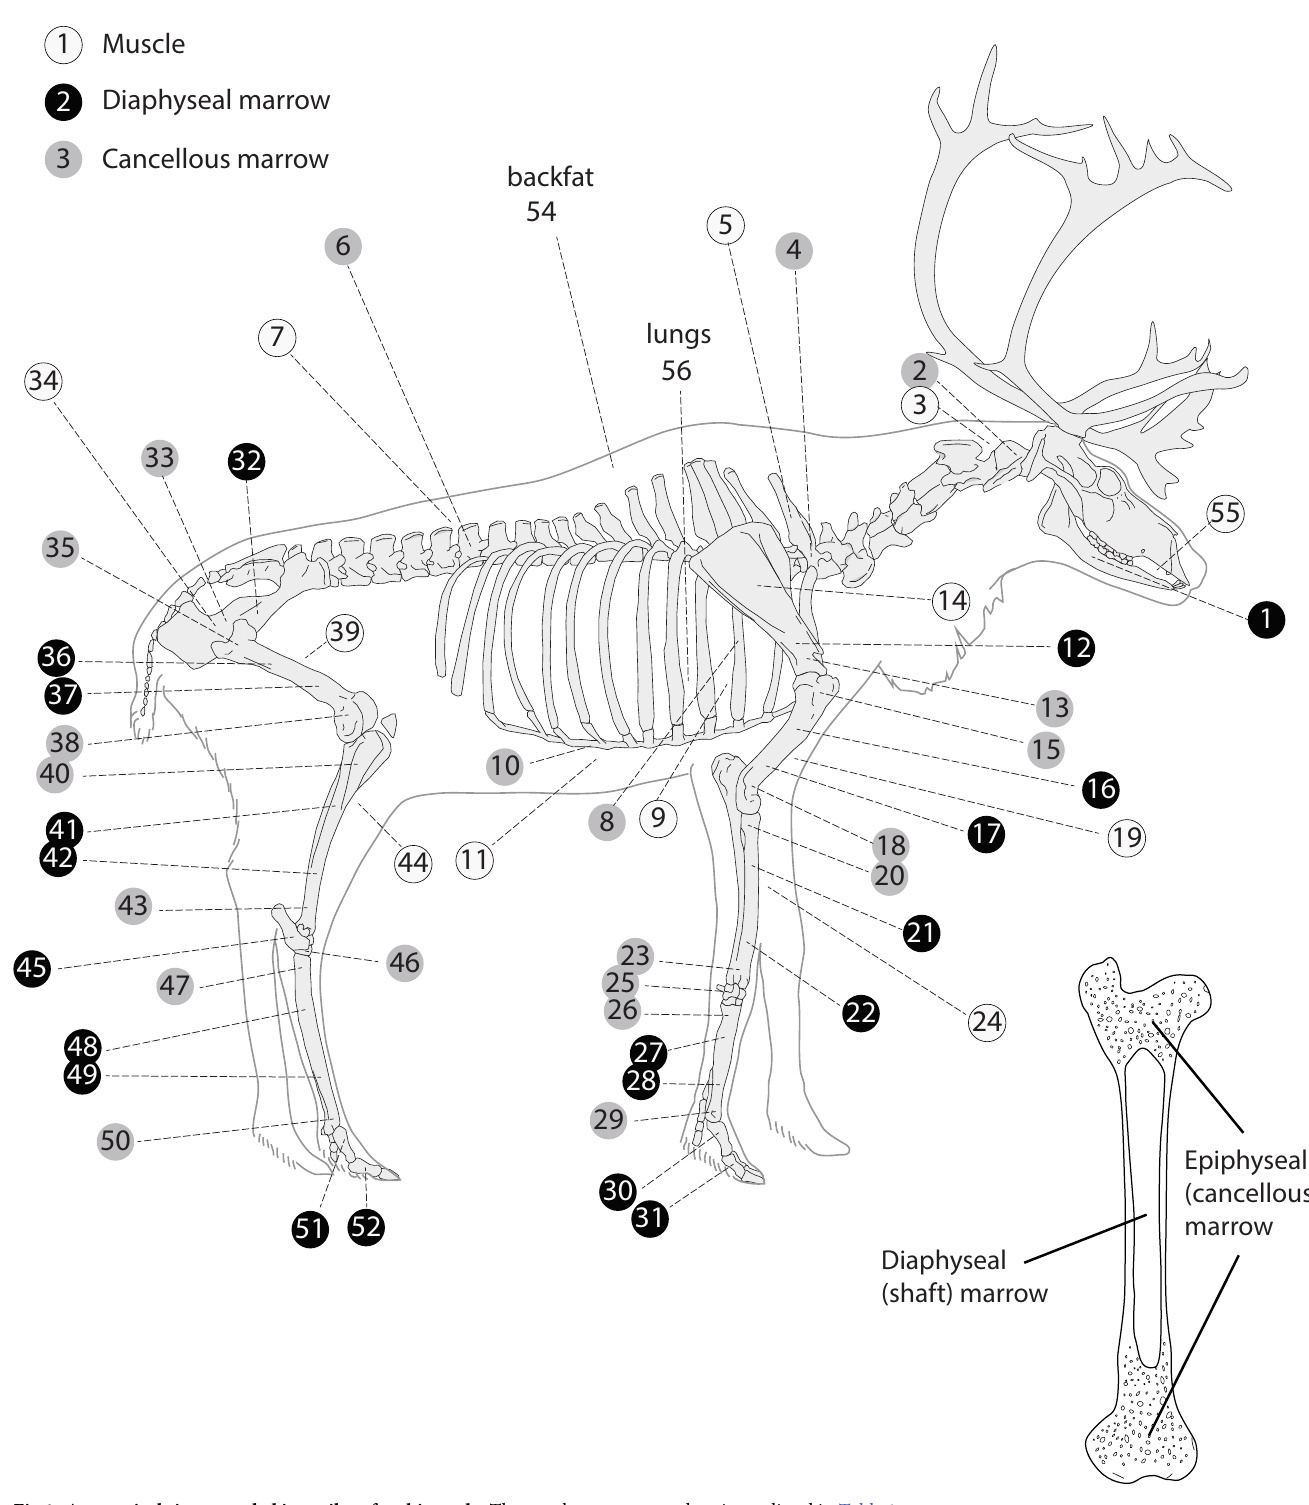
Fig 1. Anatomical sites sampled in caribou for this study. The numbers correspond to tissues listed in Table 1.